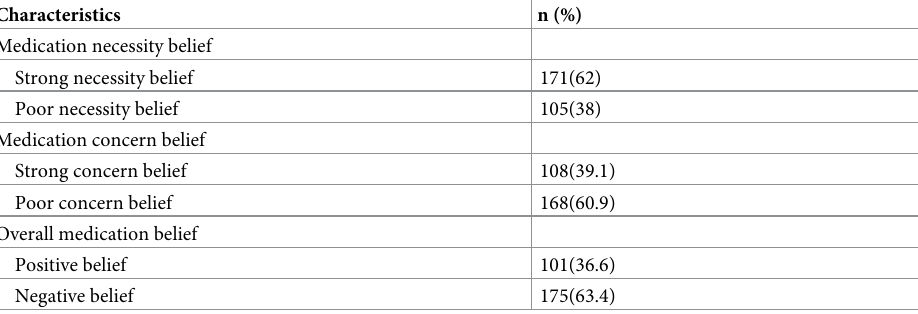
Table 2. Medication belief of hypertensive patients in ACSH, 2017 (n = 276). Characteristics